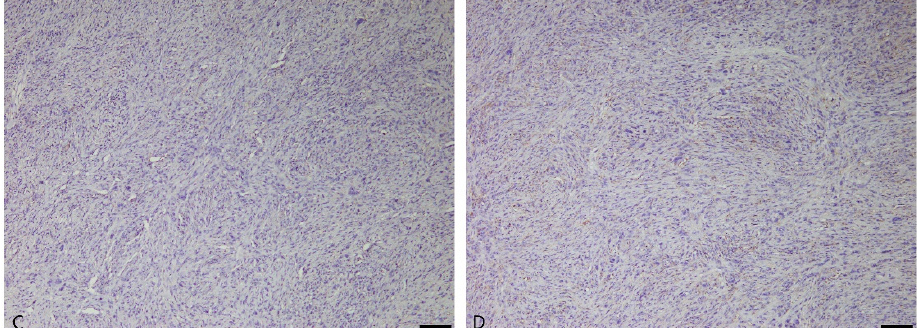
Figure 5. Stromal sarcomas in the spleens of different dogs. ( A ) The spindle-shaped neoplastic cells formed haphazard, interlacing fascicles. Hematoxylin and eosin (H&E) at 100× magnification. Scale bar = 100 µm. ( B ) The mesenchymal neoplastic cells contained clear cytoplasmic fat vacuoles. Bizarre nuclei were observed within lipocytes (arrow). H&E at 100× magnification. Scale bar = 100 µm. ( C ) Immunohistochemical staining for Iba1 with Mayer’s hematoxylin counterstain. Neoplastic cells were immunonegative for Iba1. 100× magnification. Scale bar = 100 µm. ( D ) Immunohistochemical staining for CD31 with Mayer’s hematoxylin counterstain. Neoplastic cells were immunonegative for CD31. 100× magnification. Scale bar = 100 µm.